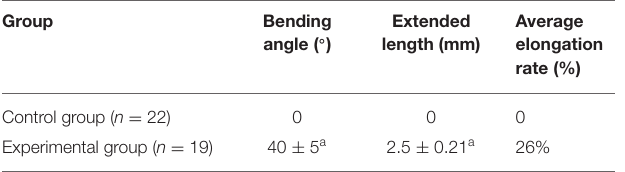
Bilateral Bilateral artery anterior posterior cerebral communicating arteries